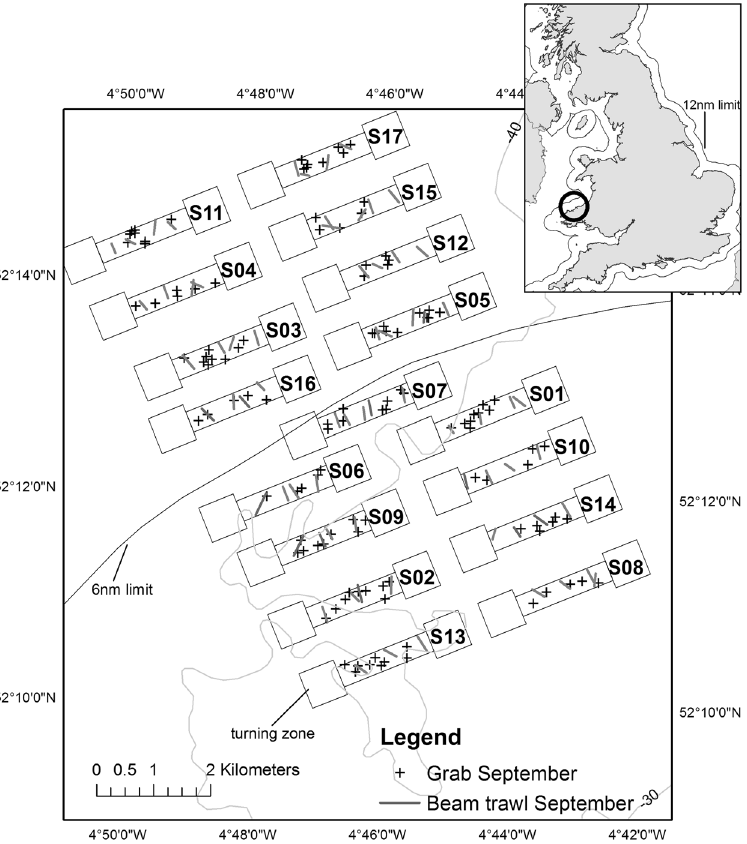
Figure 1. Map of the experimental area located within Cardigan Bay SAC, Wales, UK. Each site consisted of two turning zones and a fishing corridor in between. Sites are numbered in increasing order of designated fishing intensity (See Table 1). Sampling locations ( + ) for grabs and lines for trawls are shown for the September 2014 survey. The 6 nautical mile limit separates two distinct management zones in Wales. Within 6 nm, only vessels towing less than four dredges a side were allowed to operate, whereas the offshore sites could be fished with up to 7 dredges a side (created with ArcGIS 10.5,